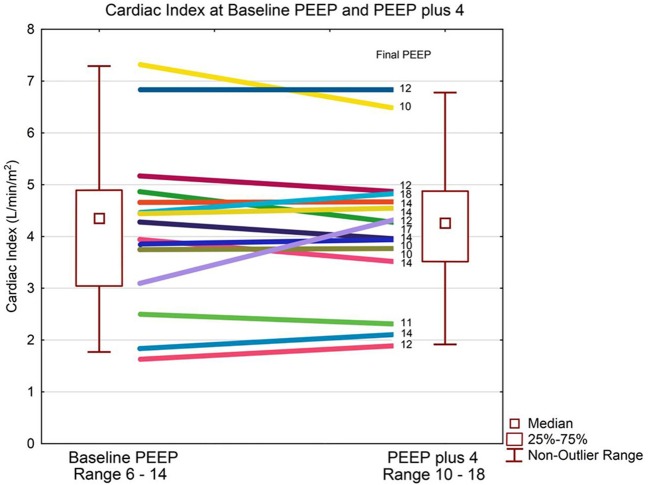
Cardiac index and PEEP. Data are presented as median, inter-quartile, and non-outlier range. The box plot represents the entire group and each patient's change in cardiac output is displayed as a line diagram with the change from baseline PEEP to PEEP plus 4 cmH2O. There is no statistically significant change in cardiac index at median PEEP of 8 cmH2O compared to median PEEP of 12 cmH2O.